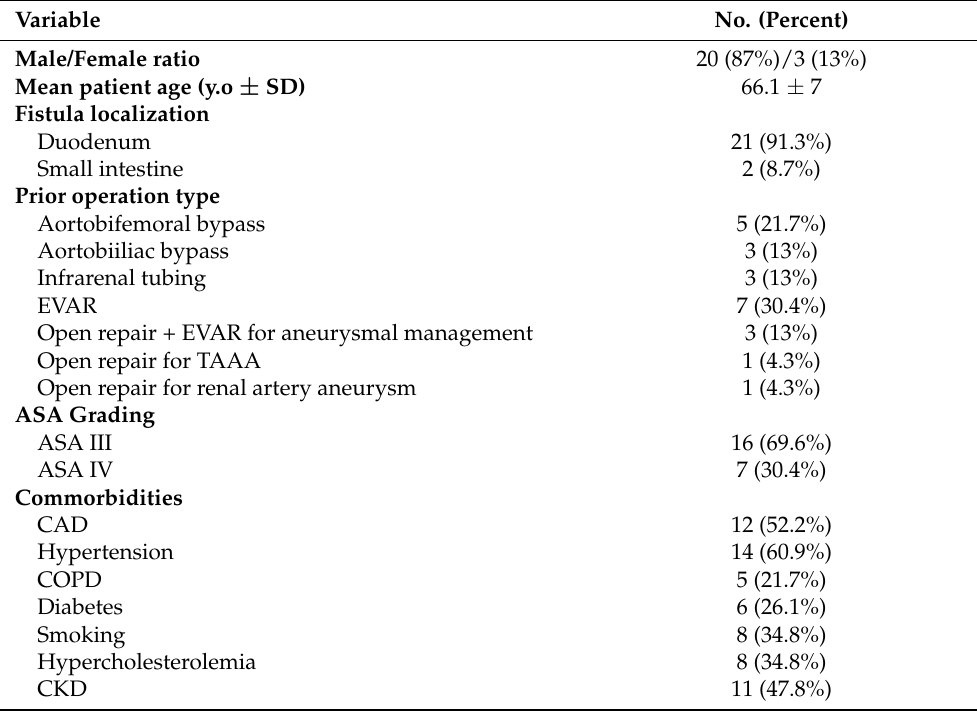
Table 1. Patient demographics. No = number; y.o = years old; SD = standard deviation; EVAR = endovascular aneurysm repair; TAAA = thoracoabdominal aortic aneurysm; ASA; Ameri- can Society of Anesthesiology score; CAD = coronary artery disease; COPD = chronic obstructive pulmonary disease; CKD = chronic kidney